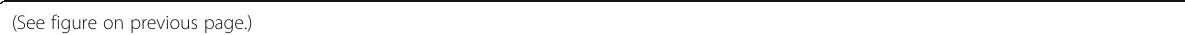
The Sclerenchymatous Cells are Defective on the Abaxial Side of OE- AGO1b